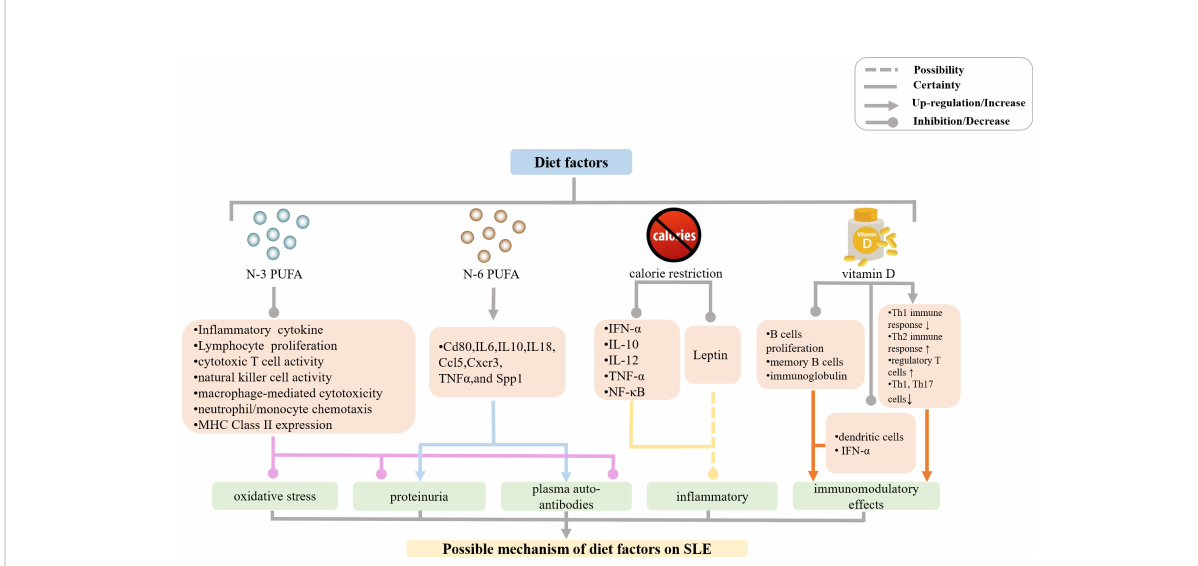
FIGURE 1 Mechanisms of diet effects on SLE incidence and manifestations. (PUFA, polyunsaturated fatty acids; MHC, major histocompatibility complex; IL, interleukin; IFN, interferon; TNF, tumor necrosis factor; NF, nuclear